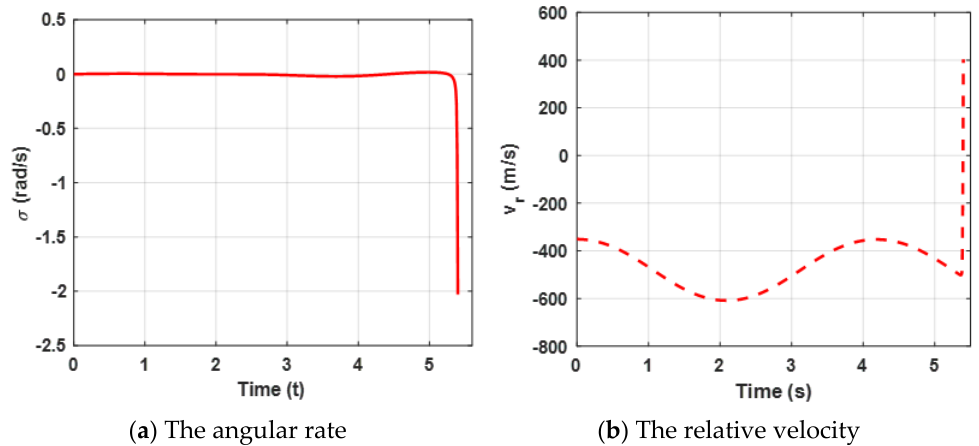
Figure 6. Engagement scenario for maneuvering target.